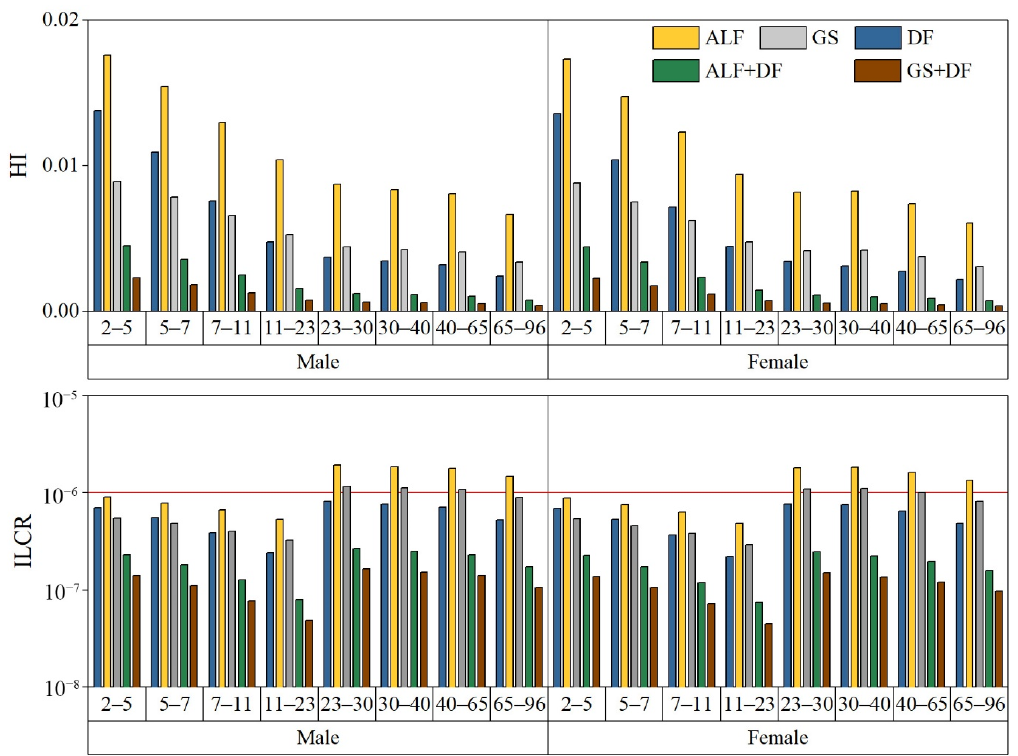
Figure 3. Human health risk assessment of HI and ILCR values of different ages groups for different evaluation concentrations. ALF (yellow portion of bars): artificial lysozyme fluid, represents the result of PM 2.5 dissolved in acidic simulated lung fluid (pH = 4.5 ± 0.1); GS (the grey portion of bars): Gamble solution, represents the result of PM 2.5 dissolved in neutral simulated lung fluid (pH = 7.4 ± 0.2). DF (blue portion of bars): the result of PM 2.5 deposition fraction; ALF + DF (green portion of bars): the result of PM 2.5 deposition dissolved in the ALF; GS + DF (the brown portion of bars): the result of PM 2.5 deposition dissolved in GS. The solid red line indicates the value of potential carcinogenic risk.